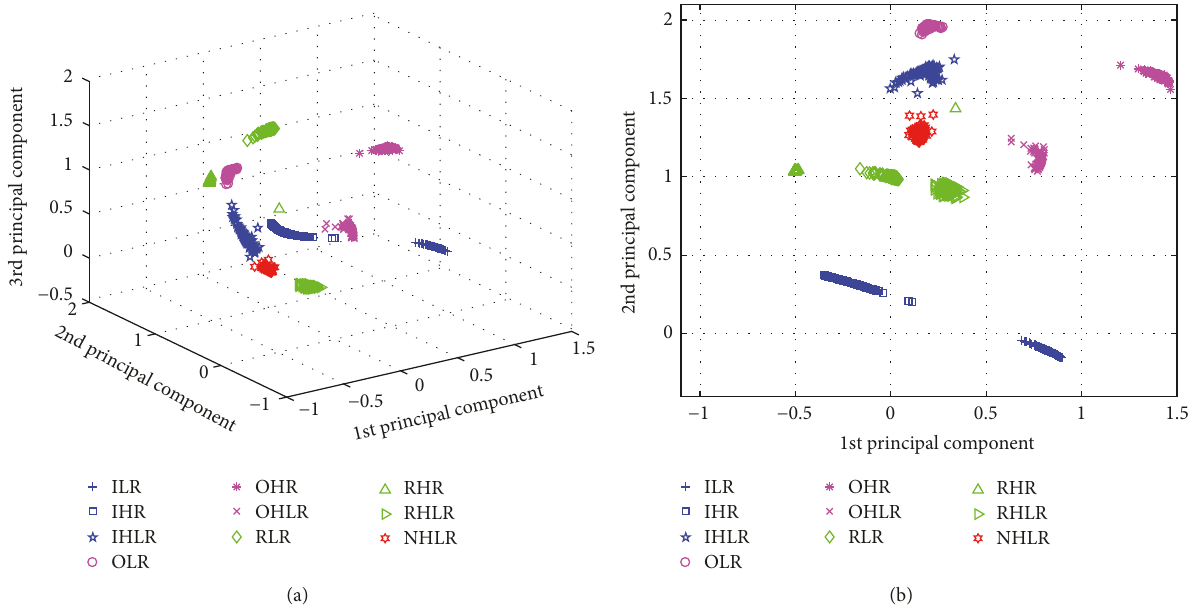
Figure 14: Feature visualization maps of the proposed method in Experiment 2. (a) The first three PCs; (b) the first two